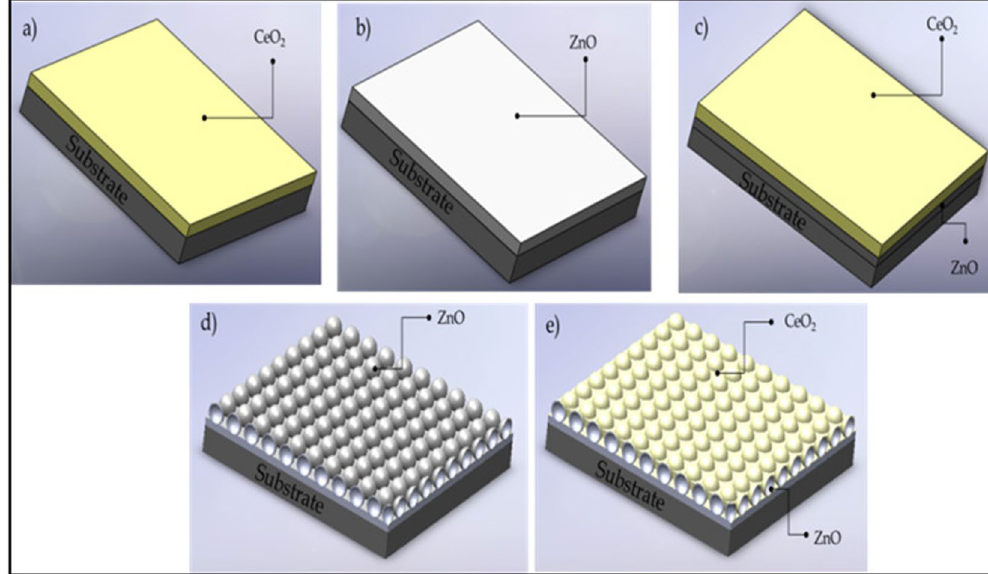
Figure 1. Morphologies used in this study: ( a ) CeO 2 , ( b ) ZnO and ( c ) CeO 2 -coated ZnO films, and; ( d ) ZnO and ( e ) CeO 2 -coated ZnO spherical nanoshells. All samples were deposited on both Si (100) and quartz